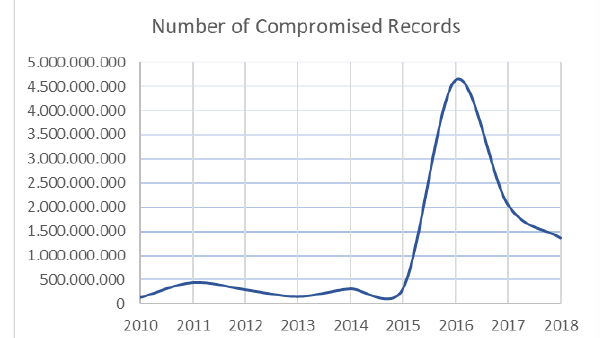
Figure 4. Progress of the number of compromised records, annually, in data breach events (data source: privacyrights.org).